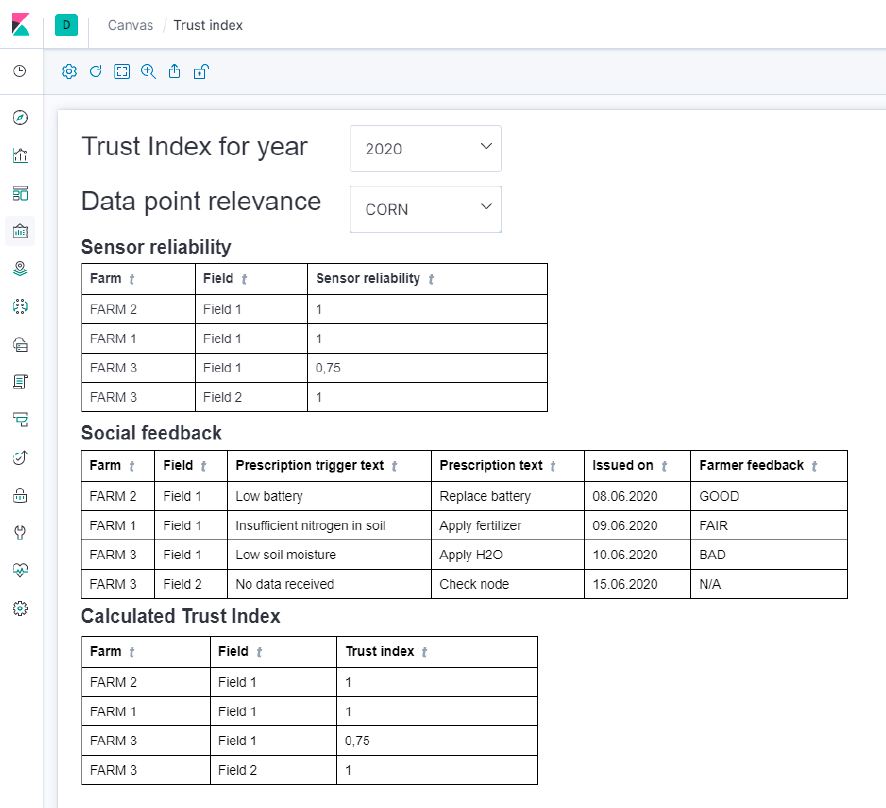
Figure 20. Initial Social Trust Index Visualized in the Analytics Platform.